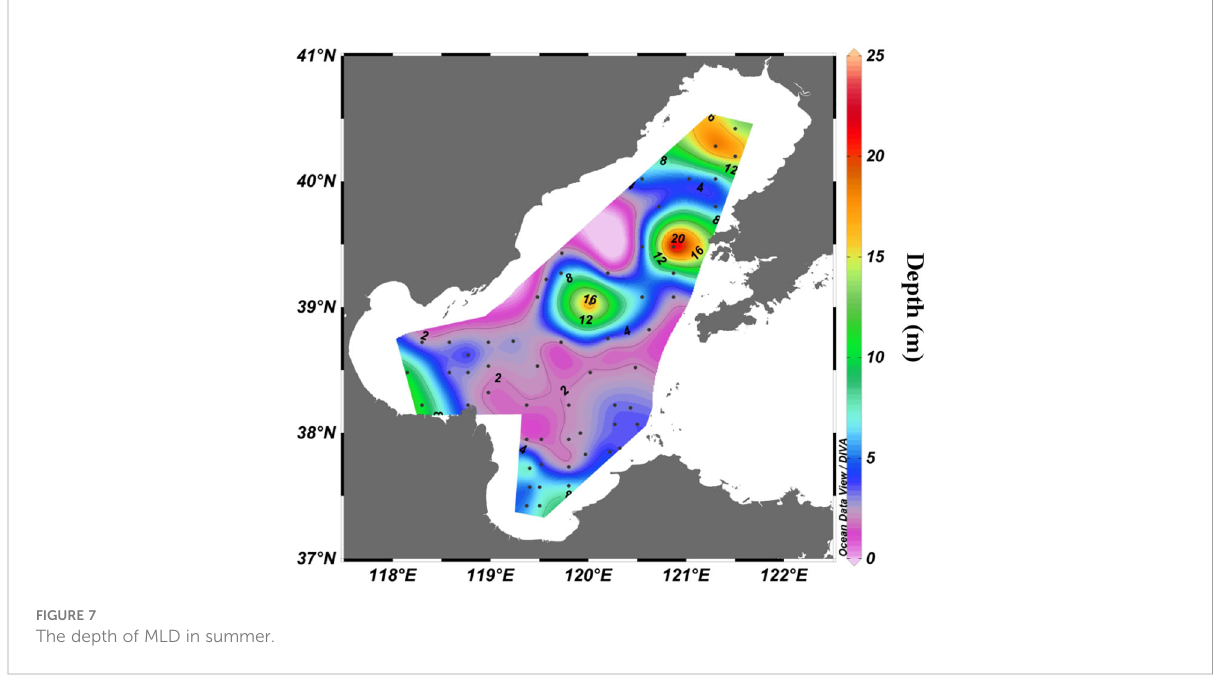
FIGURE 7 The depth of MLD in summer.